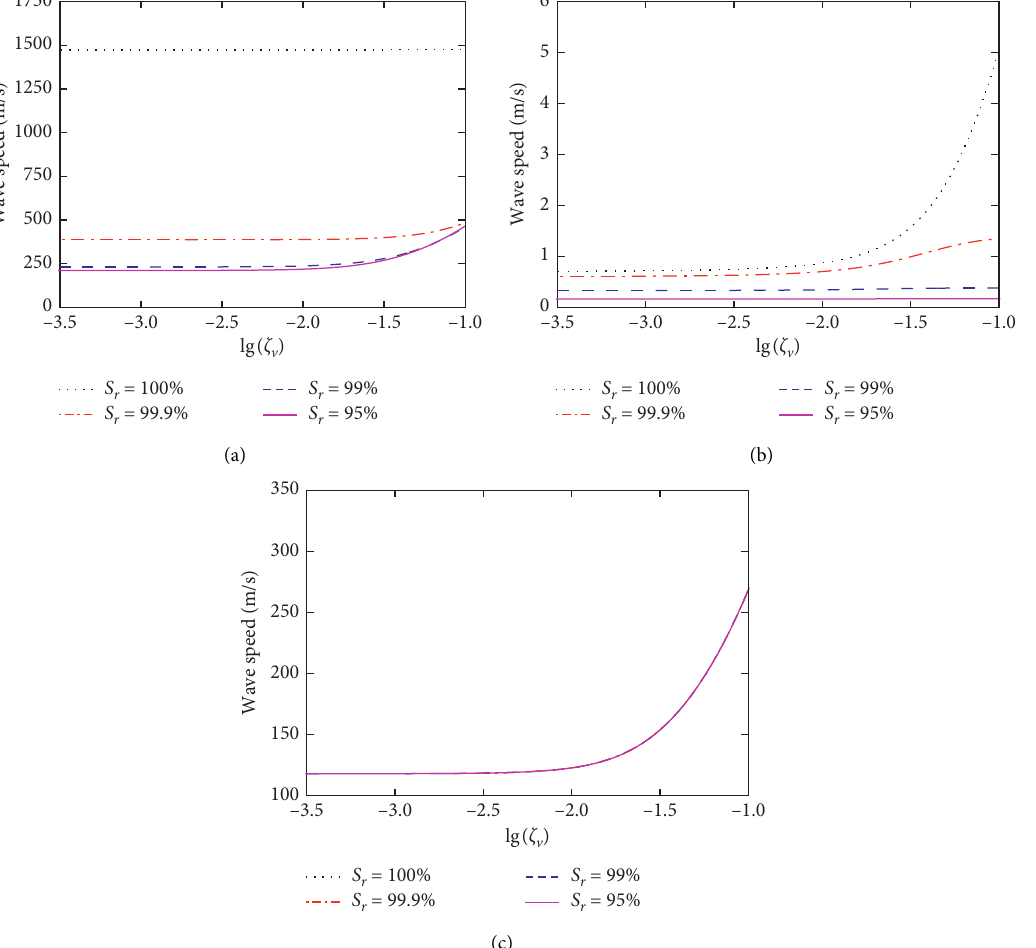
Figure 4: Variation of wave speeds of P1, P2, and S waves with damping coefficient ξ